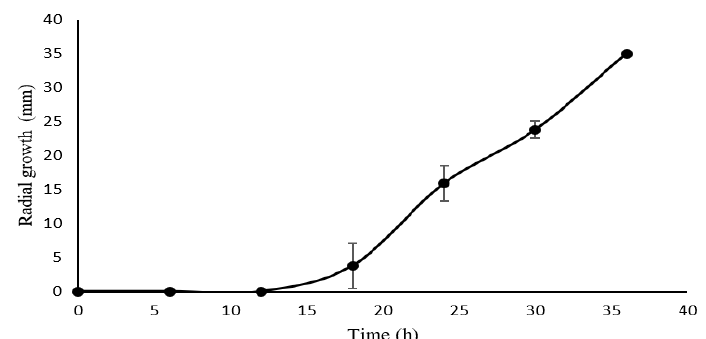
Figure 1. Kinetic of radial growth of Aspergillus niger GH1 on Castilla Rose.